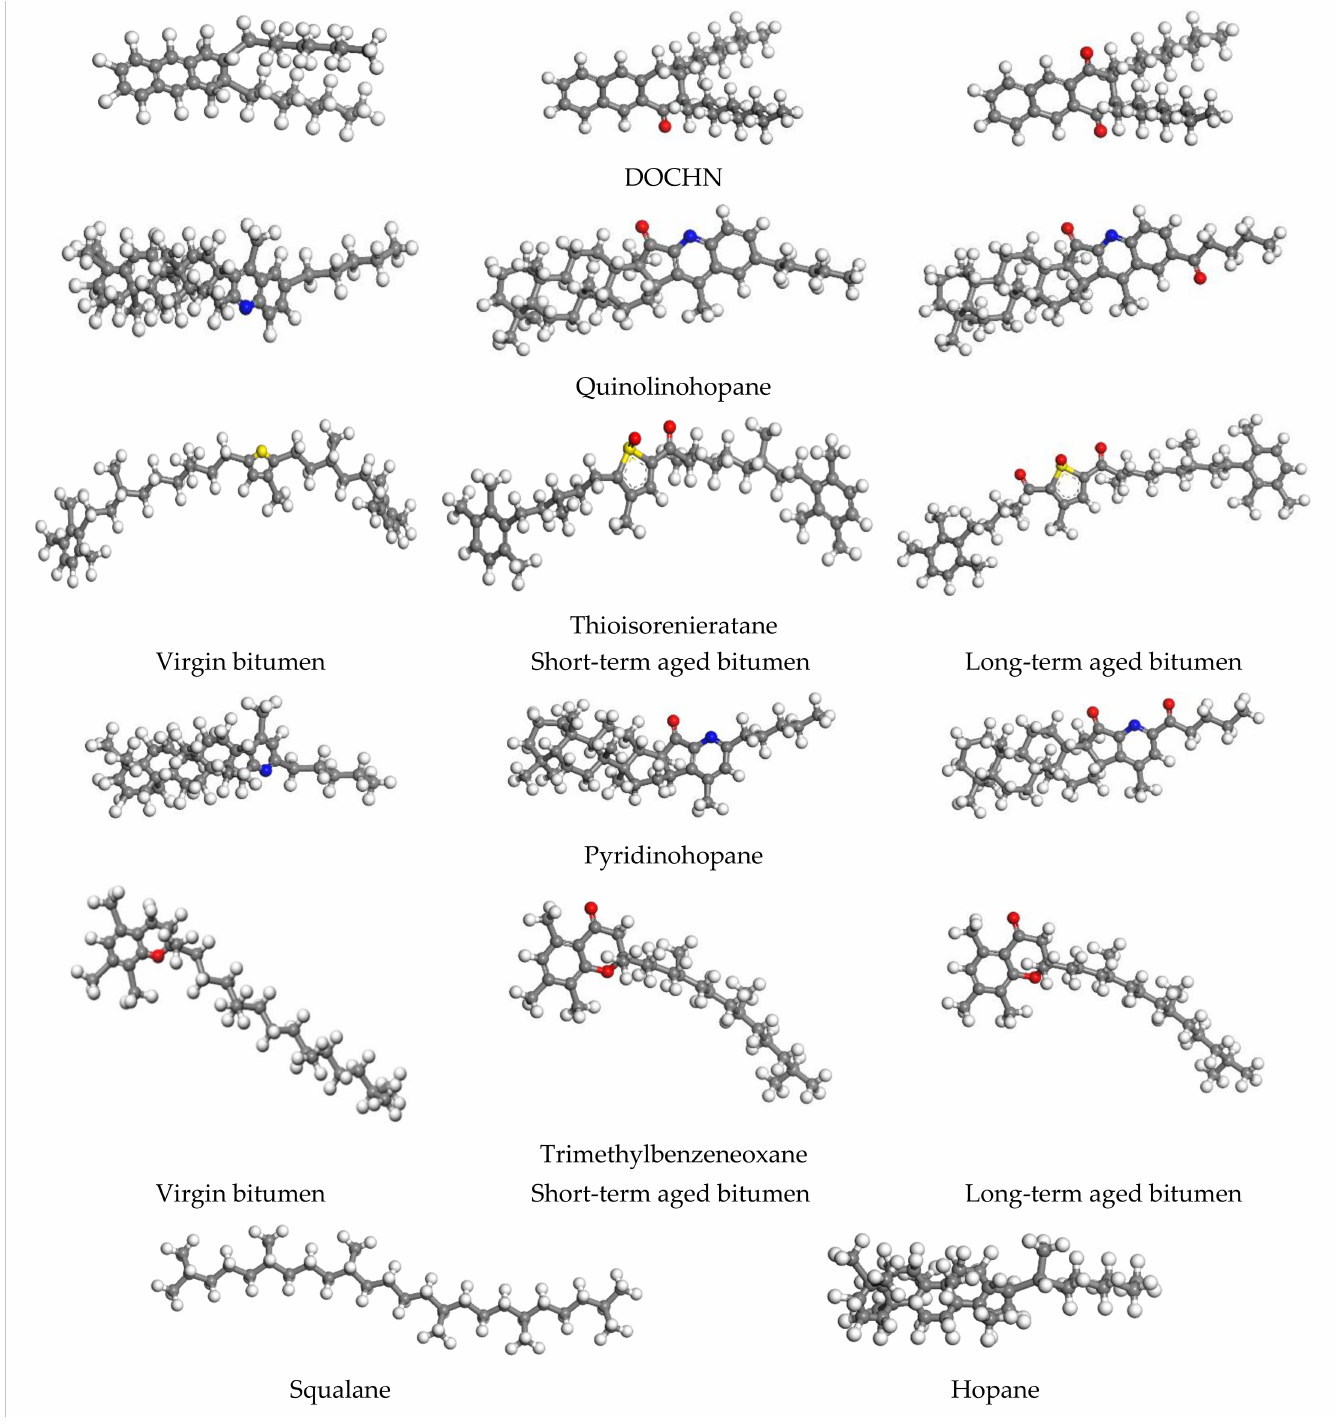
Figure 21. Molecular structures of 12-component bitumen model with different aging levels. (Carbon atoms are grey, hydrogen atoms are white, oxygen atoms are red, sulphur atoms are yellow, and blue is